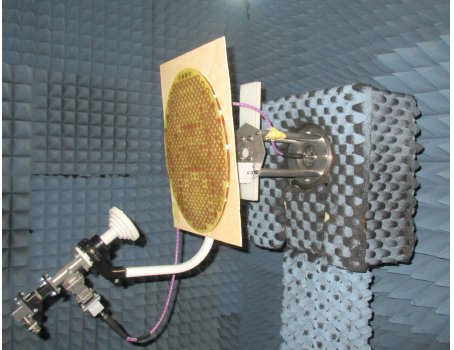
Figure 9. Manufactured reflectarray prototype assembly for characterization in the anechoic